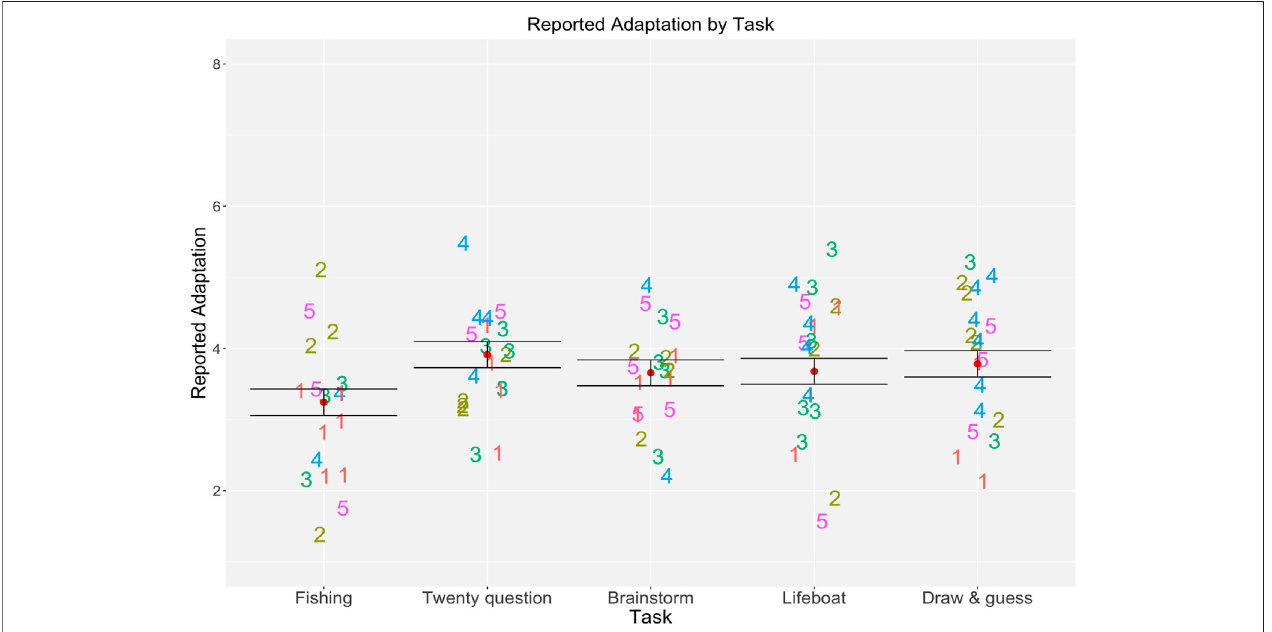
FIGURE 10 | Adaptation reported by participants for each task for all sessions. Red dots represent mean and black bars show standard error of the mean (SE). Numbers on the plot shows session the number and the position of the number is associated with the reported workload.